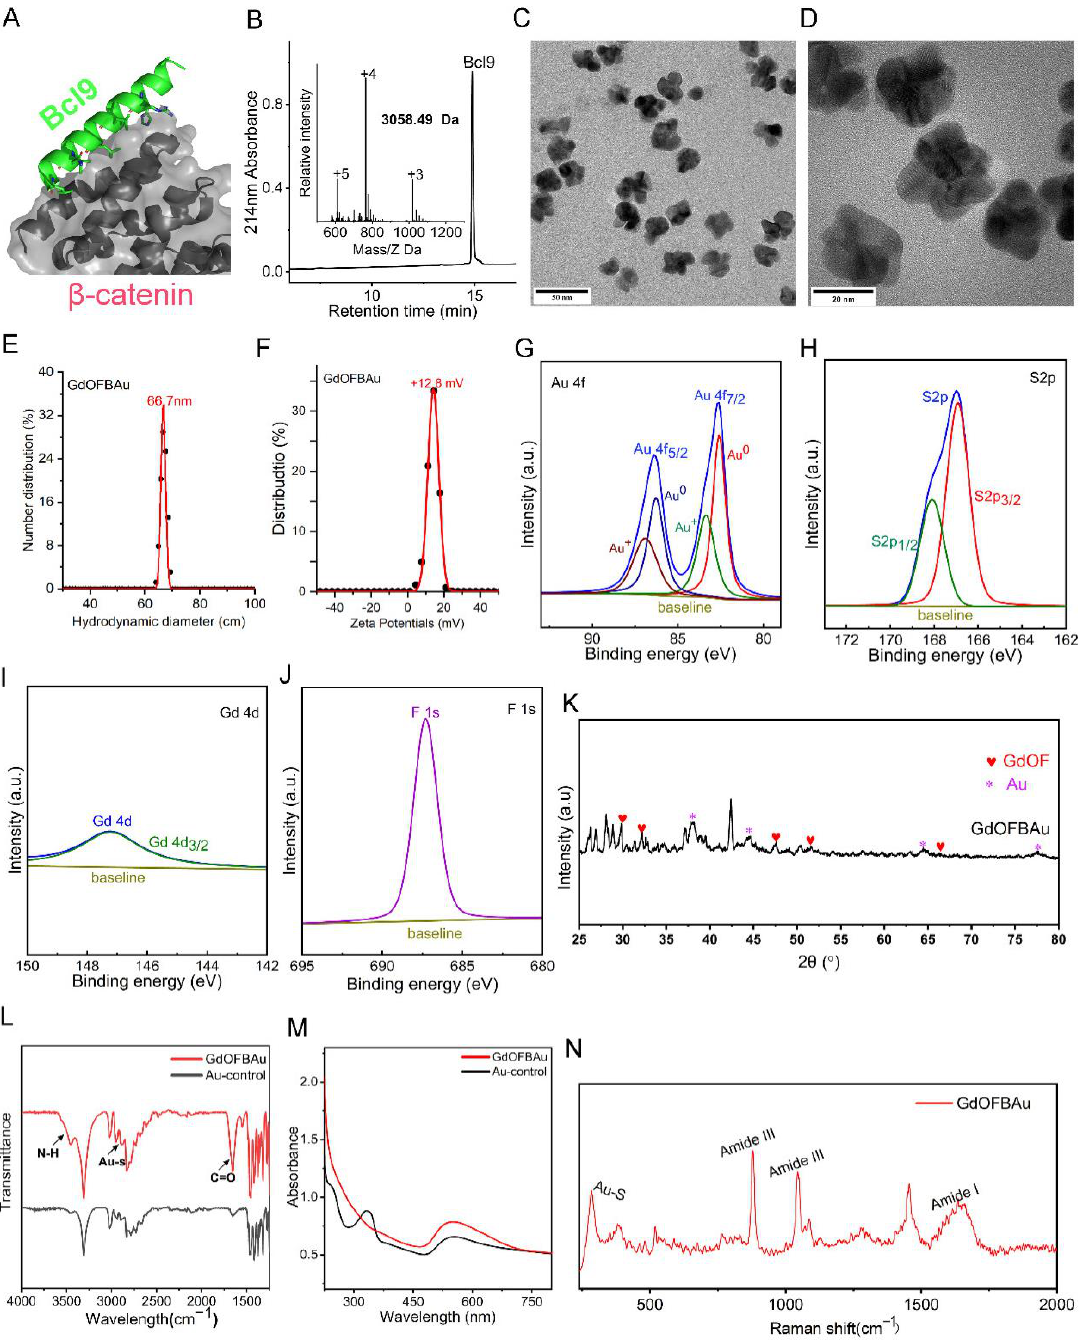
Figure 2. Characterization of GdOFBAu. ( A ) Molecular docking simulated structures of Bcl9 peptide aligned with β -catenin. ( B ) Characterization of Bcl9 by HPLC and ESI-MASS. ( C , D ) HRTEM images of GdOFBAu. ( E ) Hydrated particle size distribution of GdOFBAu determined by DLS. ( F ) Zeta potential of GdOFBAu. ( G – J ) XPS spectrum of Au ( G ), S ( H ), Gd ( I ), and F ( J ) elements in GdOFBAu. ( K ) XRD of GdOFBAu. ( L ) UV – VIS absorption spectra of GdOFBAu, scan range: 200 – 900 nm, solvent: deionized water. ( M ) FT – IR spectra of GdOFBAu powder measured by potassium bromide compression. ( N ) Raman spectra of GdOFBAu powder under excitation at 785 nm.